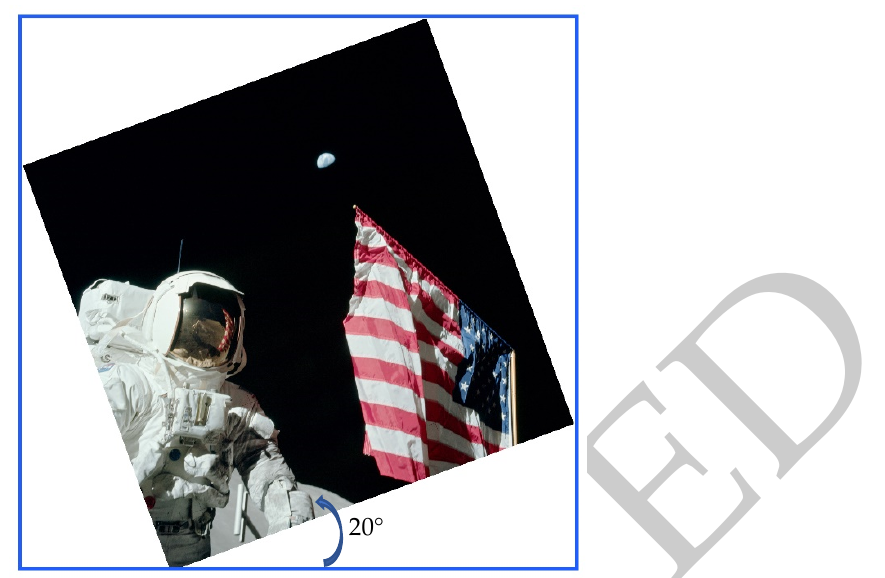
Figure 9. The image was taken at an angle of 20° to the horizontal.